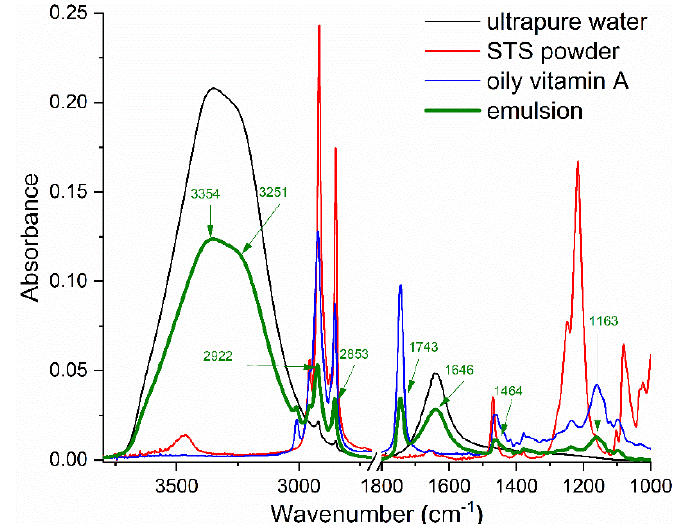
Figure 1. FTIR–ATR spectra of emulsion and its components (ultrapure water, sodium tetradecyl sulfate (STS) powder, and oily vitamin A).